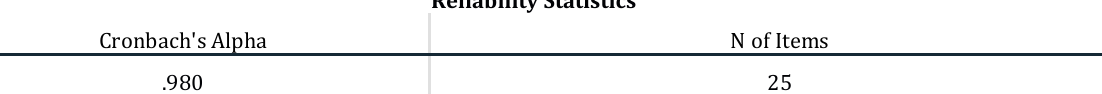
Table 2. The Reliability Test of the Technological Competency of the Caring in Nursing Instrument Indonesian Versus